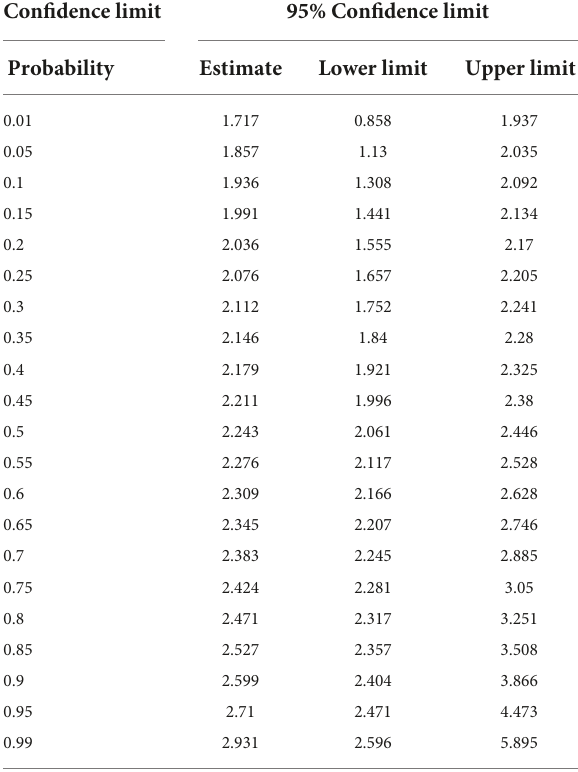
TABLE 2 Confidence interval of remifentanil effective